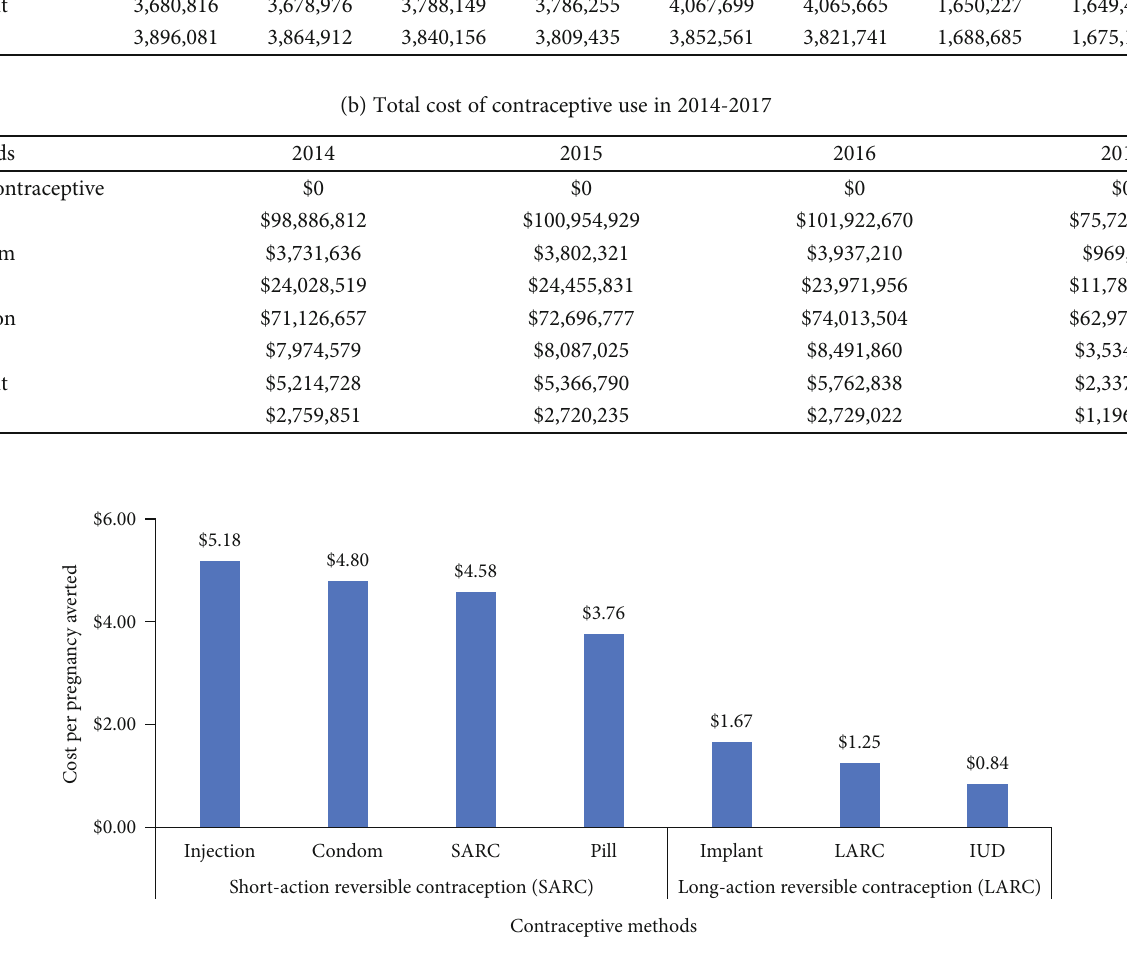
Figure 2: Cost-e ff ectiveness values among contraceptive